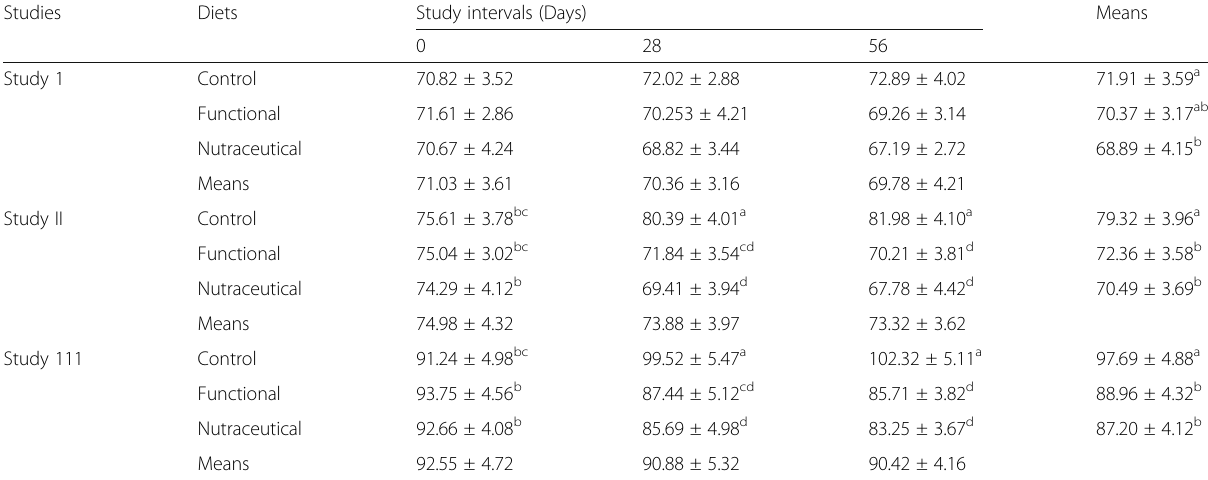
Table 5 Effect of diets and study intervals on triacylglycerol level (mg/dL) of rats in different studies Studies